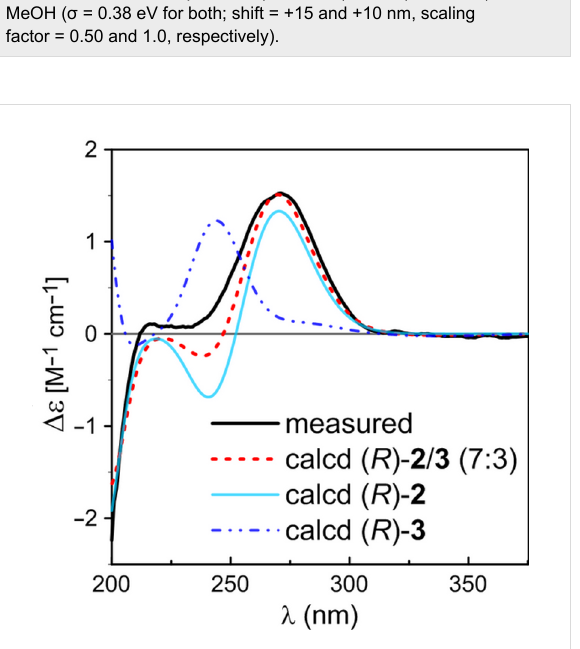
Figure 4: Comparison of the experimental ECD spectrum with the BH&HLYP/TZVP calculated spectra of the mixture of ( R )- 2/3 (7:3) and individual ( R )- 2 and ( R )- 3 in MeOH ( σ = 0.38 eV, shift = +18 nm, scaling factor = 0.44, 0.14, and 0.13, respectively).